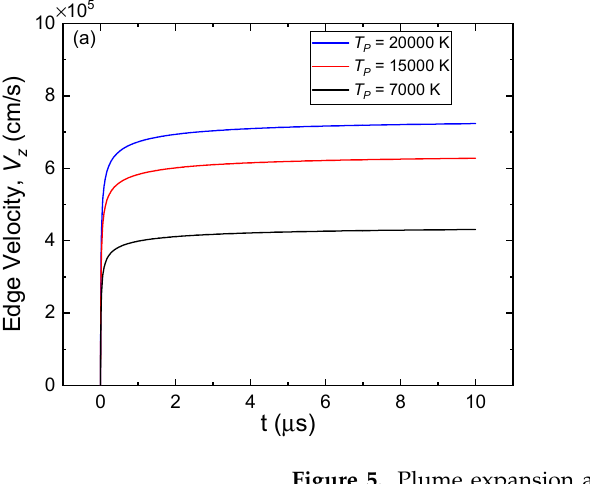
Figure 5. Plume expansion after the termination of laser for initial plasma plume temperature, T P = 20,000, 15,000 and 7000 K. ( a ) Edge velocity or center mass velocity, V z and ( b ) The height of plume edge in the z -direction, Z ( t ) .